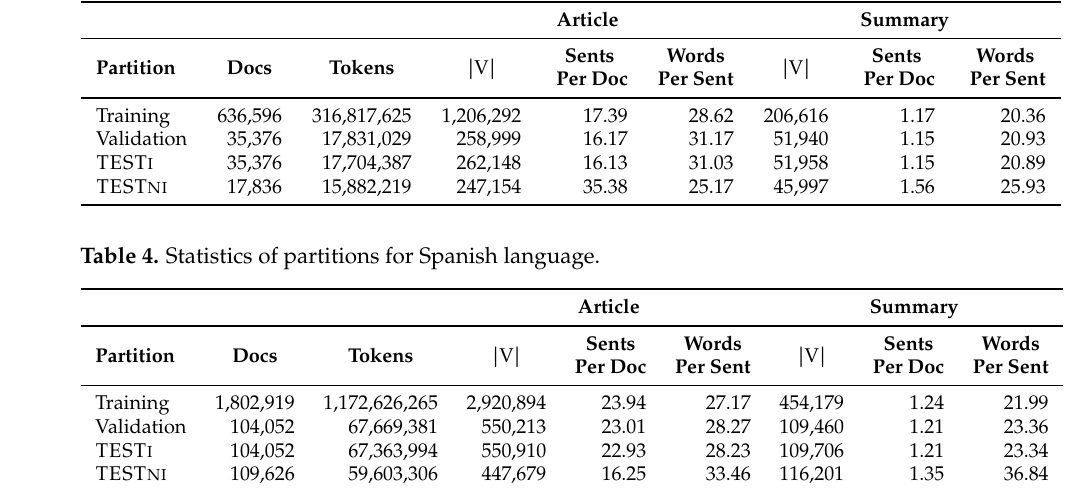
Table 3. Statistics of partitions for Catalan language.